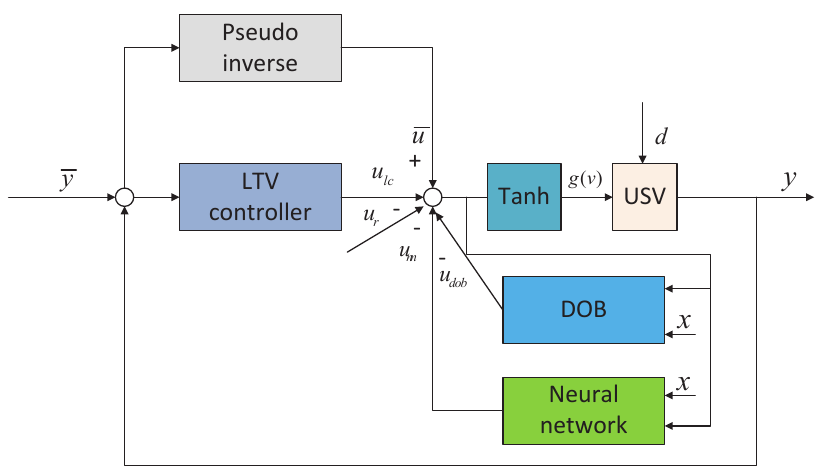
Figure 3. Logic Diagram of course control